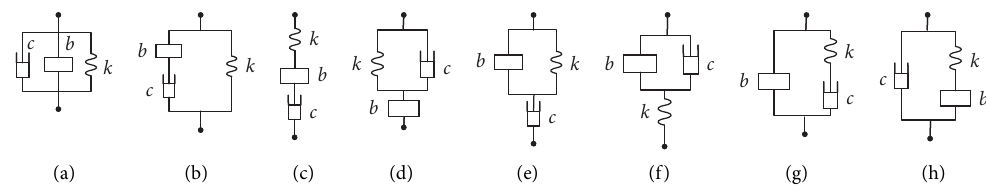
Figure 2: The low-complexity networks with only one inerter, one spring, and one damper [35]. C4 is TID [39, 40], and C6 is TVMD [38].